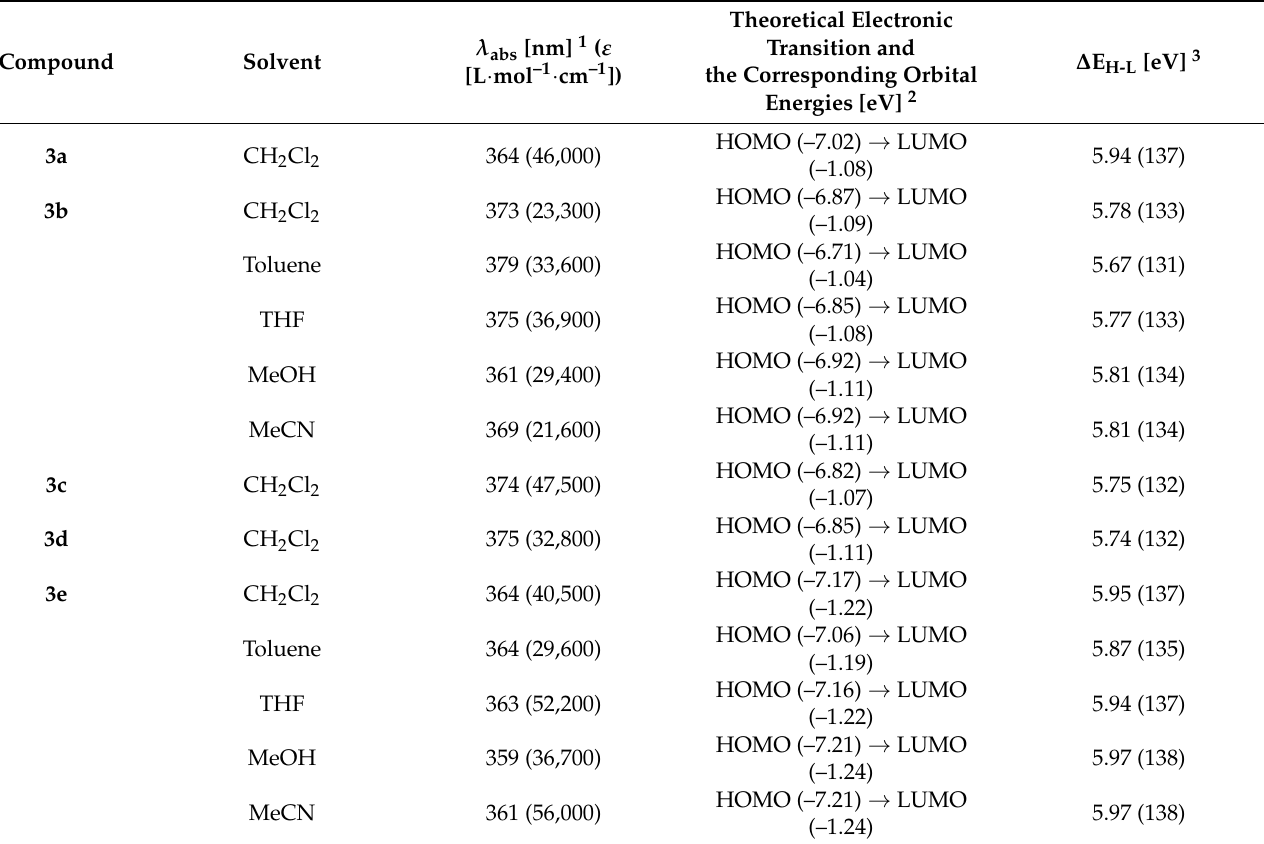
Figure 5. ( a ) UV-vis absorption spectra and photographs (inset) of 3a – 3e in CH 2 Cl 2 (concentration = 1.0 × 10 –5 mol · L –1 , λ ex = 300–600 nm); ( b ) the HOMO and LUMO distribution in 3a as obtained from theoretical calculations. Table 3. Photophysical data of 3a – 3e in numerous solvents and the corresponding calculated theoretical transitions.